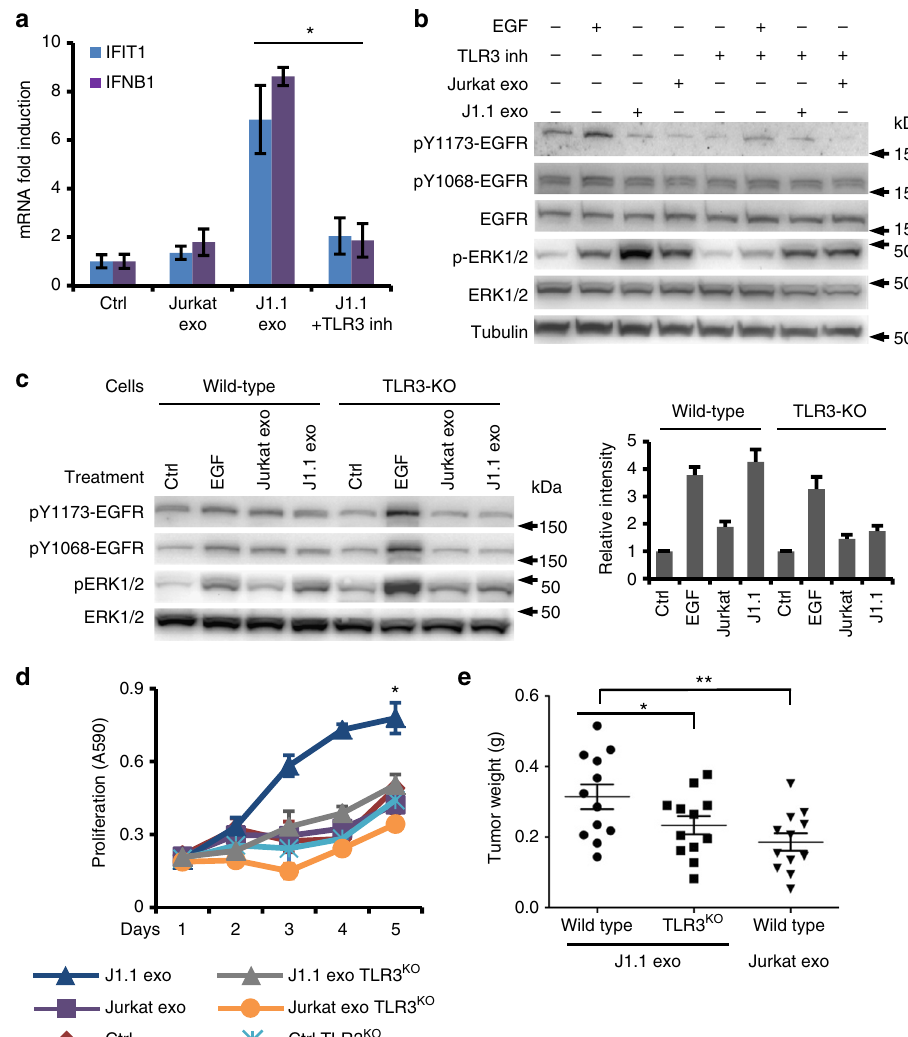
Fig. 6 TLR3 is involved in tumor-promoting function of HIV-positive exosomes. a HSC3 cells pretreated with the TLR3/dsRNA inhibitor (6 µ M, + Inh) for 30 min, or remained untreated, and then transfected with TAR RNA (1 µ g ml − 1 ). Total RNA was used for qRT-PCR of IFIT1 and IFNB1 mRNA. Error bars, ± s. d., n = 3, * p < 0.02, F -test. Data represent one experiment from three independent repeats. b Immunoblot of HSC3 cancer cells treated with exosomes (2 × 10 9 ml − 1 ) from J1.1 or Jurkat cells in the presence or absence of the TLR3/dsRNA inhibitor (6 µ M, TLR3 inh). Uncropped blot images in Supplementary Figure 4g. c Immunoblot of wild-type or TLR3-KO HSC3 cells treated with J1.1 or Jurkat cell exosomes at 2 × 10 9 ml – 1 . Right, densitometry of immunoblots over that of control. Error bars, ± s.d. Uncropped blot images in Supplementary Figure 4h. d Wild-type (Ctrl) and TLR3-KO (TLR3 KO ) HSC3 cancer cells were treated with exosomes (4 × 10 9 ml − 1 ) from J1.1 or Jurkat cells for proliferation assays. Data (mean ± s.d., n = 3) represent one experiment from three independent repeats; * p < 0.05, one-way ANOVA on days 3 to 5. e Tumor growth of wild type and TLR3-KO HSC3 (TLR3 KO ) cancer cells inoculated into nude mice in the presence of J1.1 exosomes (J1.1 exo, 6.3 × 10 9 ml − 1 ). HSC3 cells inoculated with Jurkat exosomes (Jurkat exo, 6.3 × 10 9 ml − 1 ) were used as control. Error bars represent ± s.d., n = 12, * p < 0.01 and ** p < 0.007, Student ’ s t